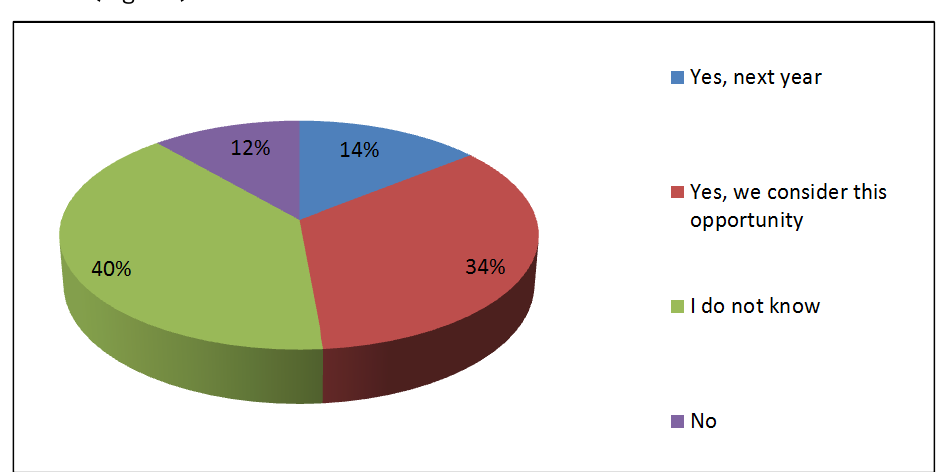
Fig. 12 Results of question 14: Do your organisation plan to participate the competition